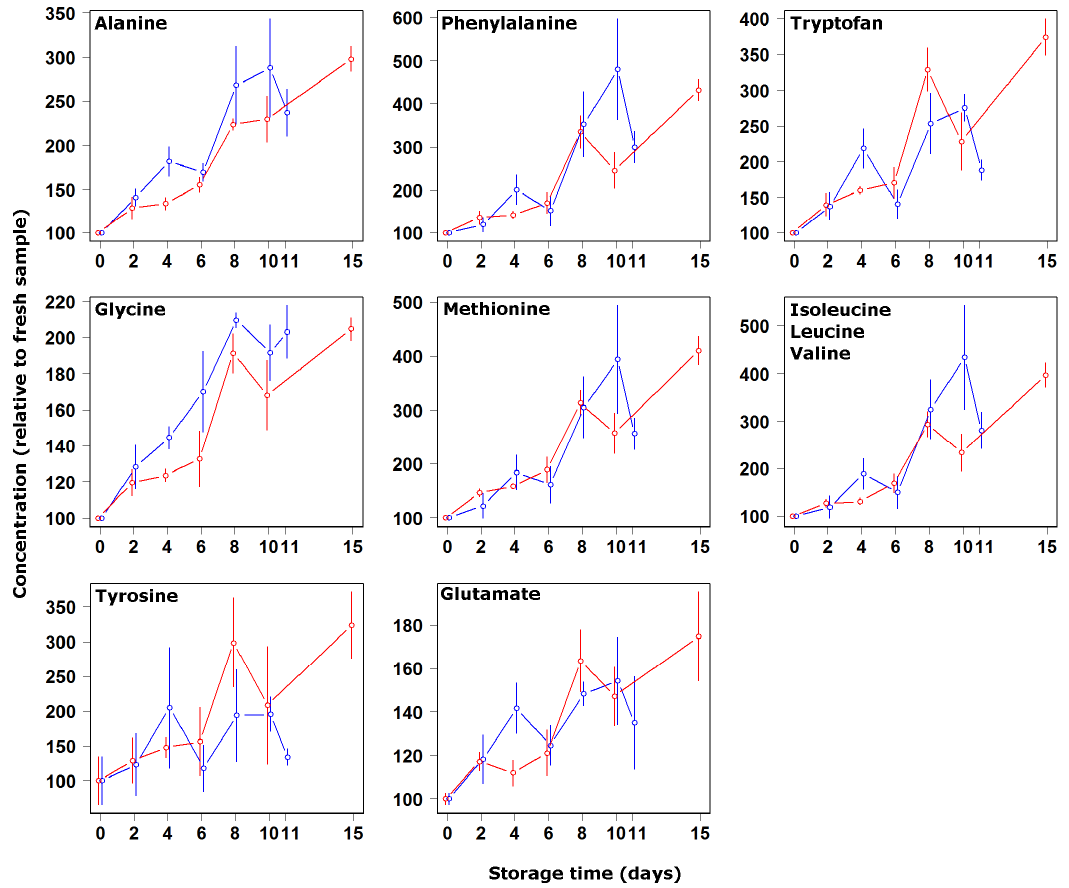
Figure 3. Concentration changes relative to fresh samples of alanine, phenylalanine, tryptophan, glycine, methionine, isoleucine-leucine-valine, tyrosine and glutamate during storage at 4 °C (blue symbols and lines) and on ice (red symbols and